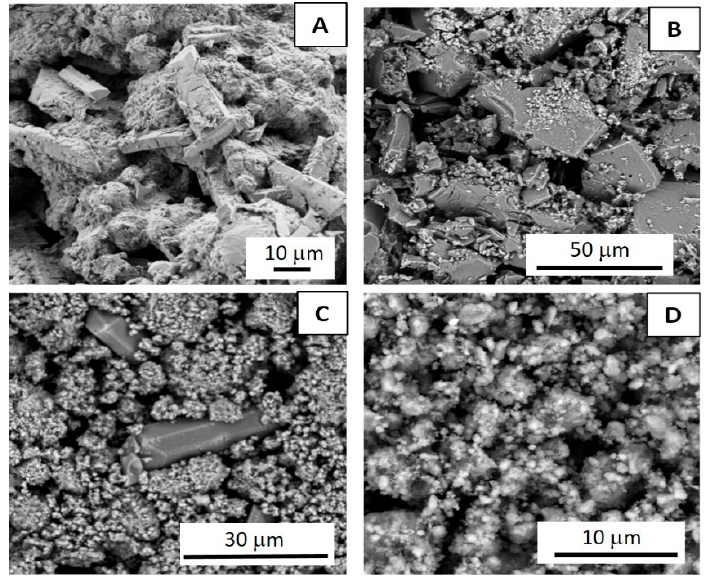
Figure 8. SEM images of MgAl 200 /K 2 HPO 4 residues after 1 h ( A ) and 168 h ( B ); and of MgFe 200 /K 2 HPO 4 residues after 1 h ( C ) and 168 h ( D ).